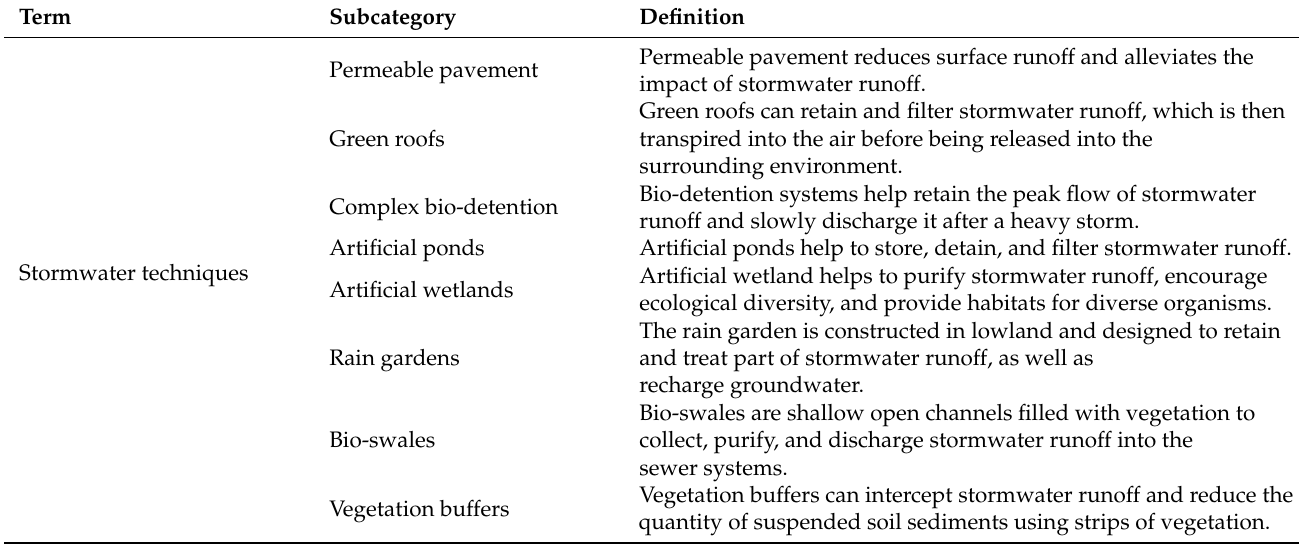
Table 1. Definitions of stormwater measures and techniques employed in SPC